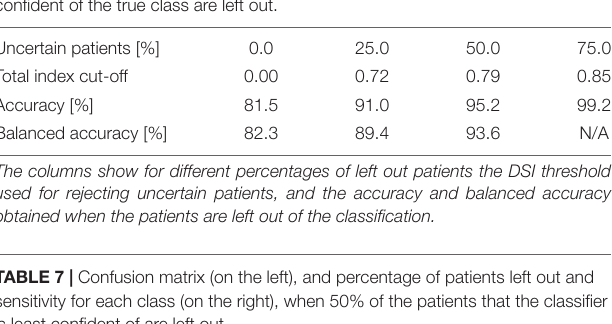
TABLE 6 | Classification accuracies when patients for which the classifier is least confident of the true class are left out. Uncertain patients [%]